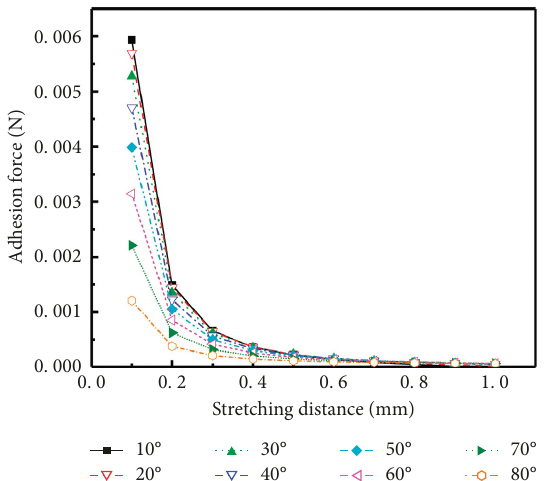
Figure 6: Variation curve of adhesion force with stretching distance under different contact angles.